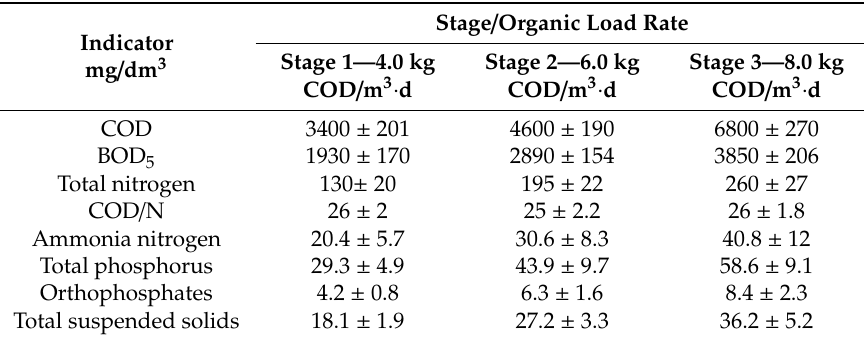
Table 1. Properties of the raw e ffl uent used in the study.